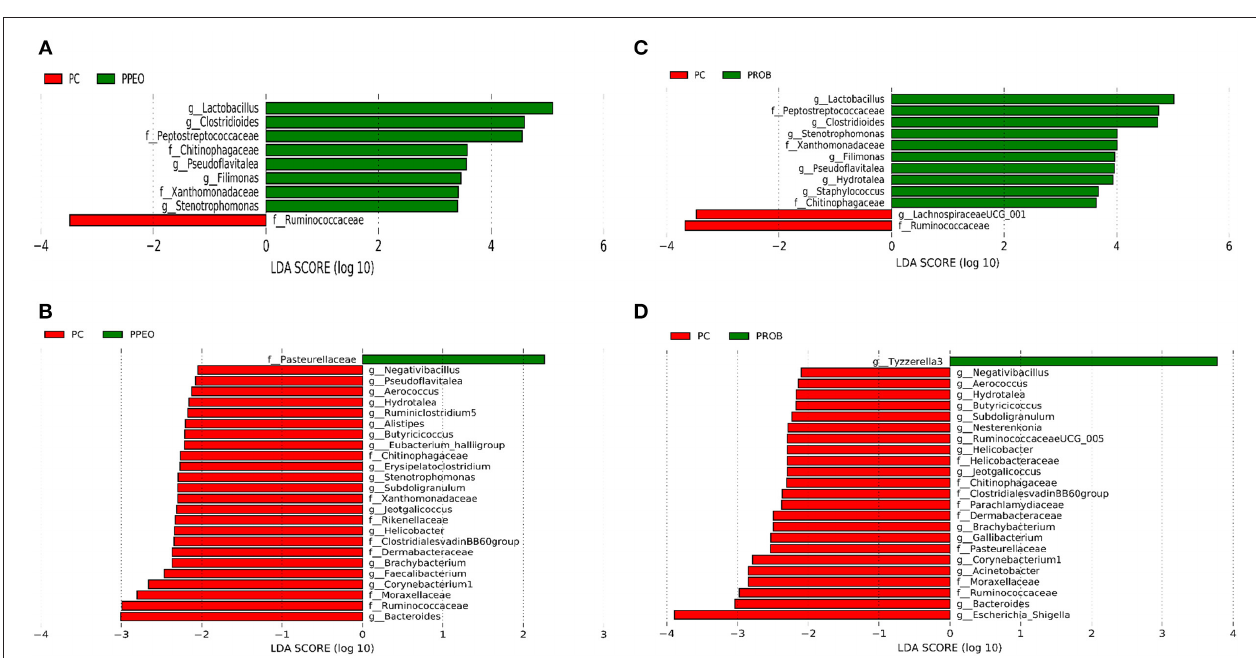
FIGURE 5 | Taxonomic biomarkers highlighted by linear discriminant analysis effect size (LEfSE) ( P ≤ 0.05 and LDA cutoff > 2.0) in ileal mucosa microbiota of broiler chickens challenged with a subclinical naturally occurring necrotic enteritis ( n = 8/treatment). (A,B) Taxonomic biomarkers in PC vs. PPEO group on d 8 and d 42, respectively. (C,D) Taxonomic biomarkers in PC vs. PROB group on d 8 and d 42, respectively. PC (positive control): basal diet (corn-soybean meal) + 20g virginiamycin (453g Stafac ® 20)/ton diet; PPEO (probiotic/prebiotic/essential oil supplement): basal diet + 453 g/ton of a supplement containing B. licheniformis spores, mannan-oligosaccharides, β -glucans (1,3 and 1,6), capsaicin, and curcuma. PROB (Probiotic): basal diet + 227g B. licheniformis spores/ton diet.